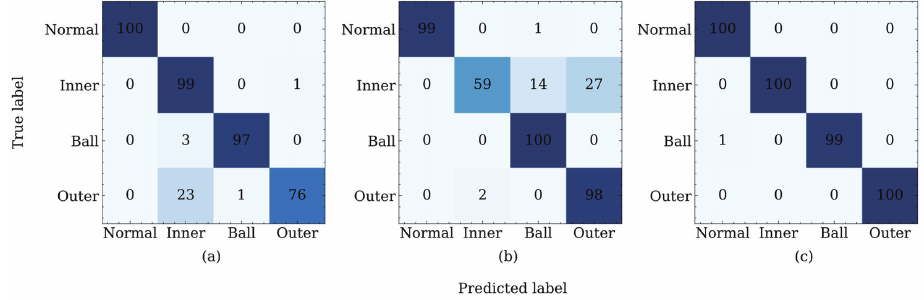
Figure 7. Confusion matrices of different methods ( a ) DANN, ( b ) ADDA, and ( c )